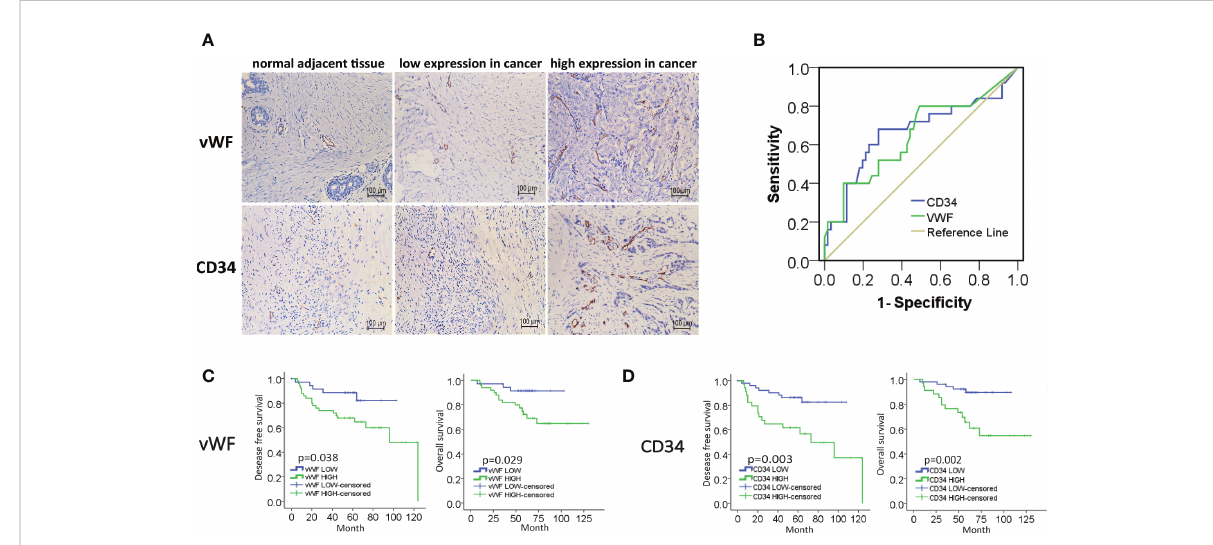
FIGURE 1 High expression of MVD predicted unfavorable prognosis of IDC patients. (A) Representative images of immunohistochemical (IHC) staining of vWF and CD34 in samples from breast invasive ductal carcinoma (IDC) patients. (B) ROC curve of the CD34 and vWF by the DFS of IDC patients. (C, D) Kaplan-Meier analysis of DFS and OS of IDC patients from our cohort by vWF and CD34.